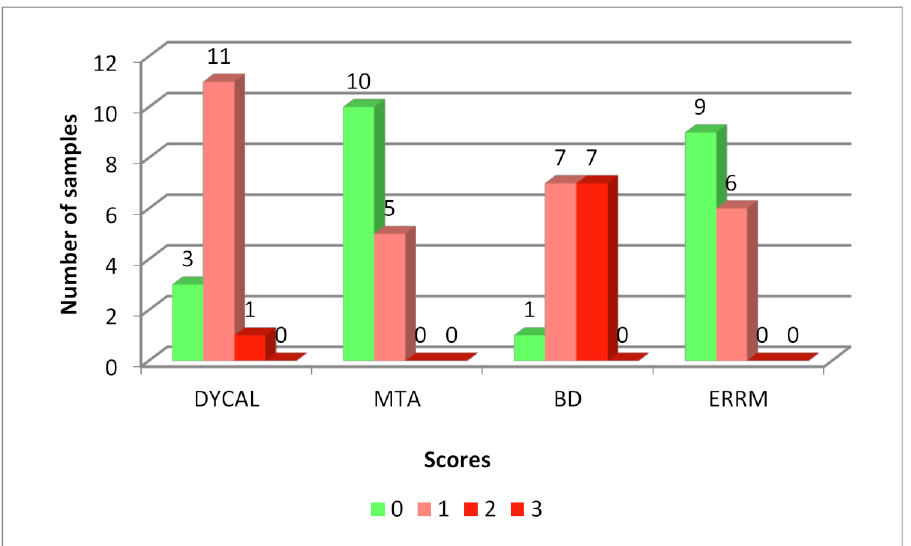
Figure 6. Pulp score comparison among the pulp-capping agents (0—no inflammation; 1—mild inflammation; 2—moderate;